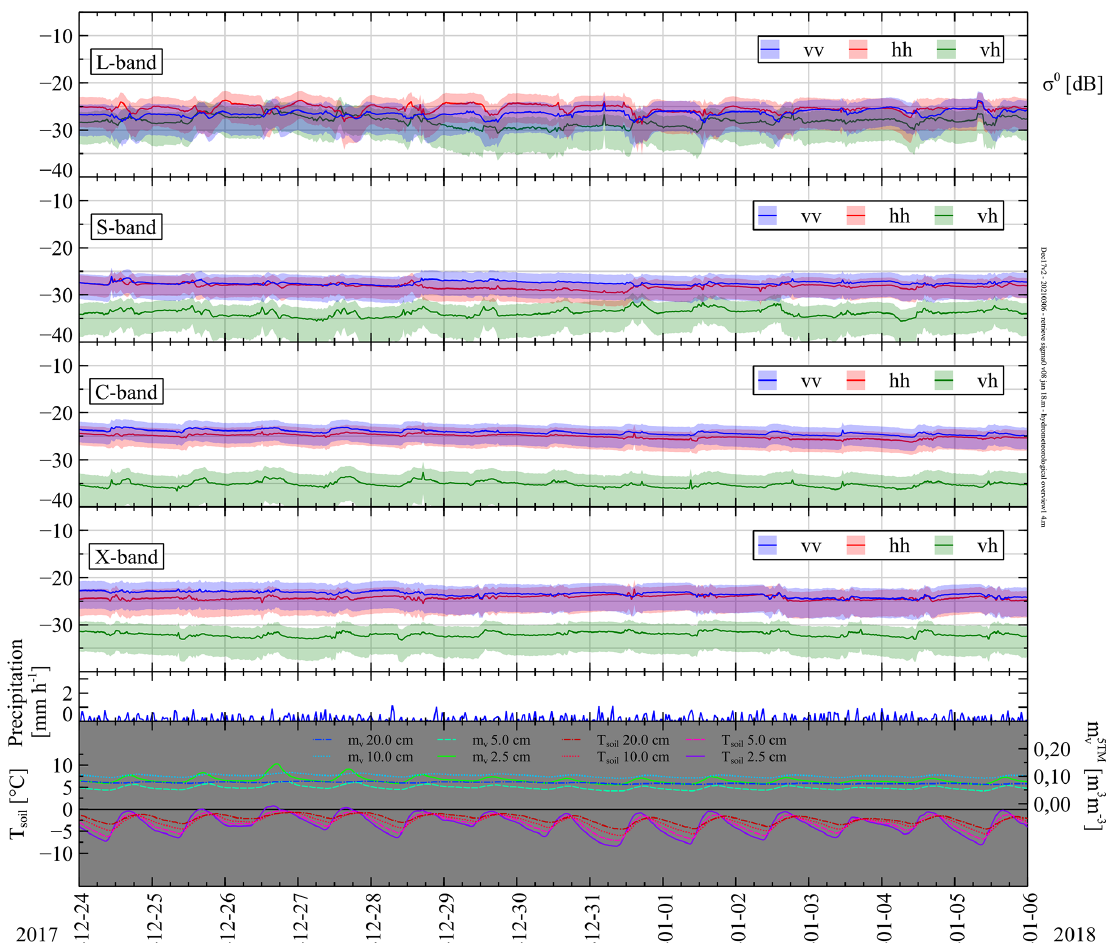
Figure D2. Time-series measurements of σ 0 pq (m 2 m − 2 ) for L-, S-, C-, and X-band, precipitation, M v , and T soil during 13d in December 2017. Same configurations as Fig. D1